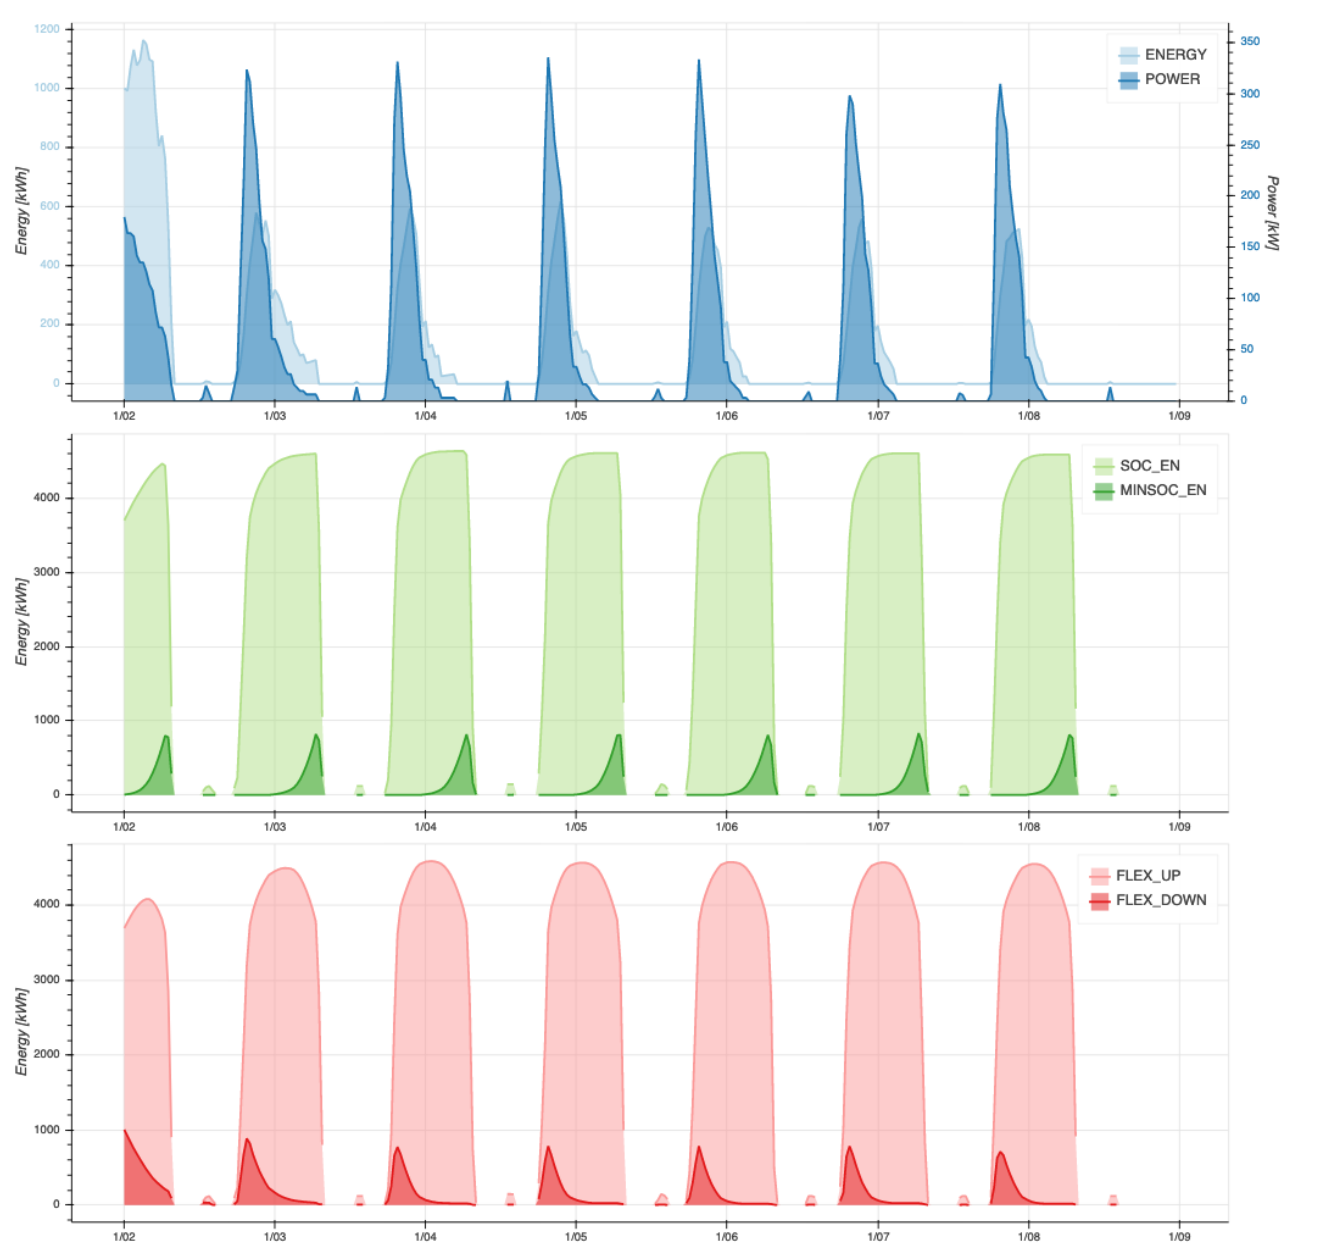
Figure 8. Aggregate output for 100 consumers, 7 days and a sampling time of 30 min. The first panel shows the supplied power and energy from the grid to the EVs. The second panel shows the EV fleet SOC and MINSOC in terms of energy for each time sample. The third panel shows the energy available to the grid from the EV fleet (pink curve) and the energy that could be supplied to the EV fleet (red curve) for each time